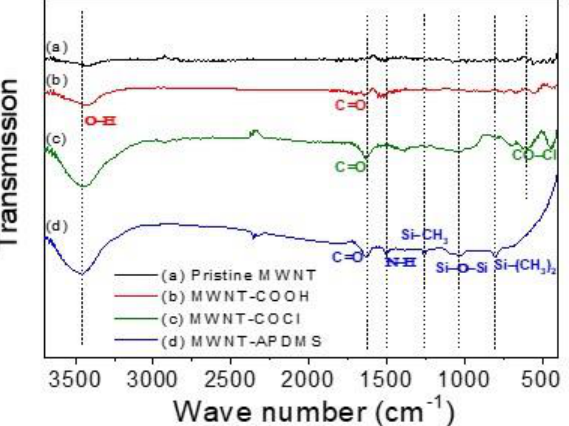
Figure 2. FT–IR spectra of the ( a ) pristine MWNT, ( b ) MWNT–COOH, ( c ) MWNT–COCl, and Figure 2. FT – IR spectra of the ( a ) pristine MWNT, ( b ) MWNT – COOH, ( c ) MWNT – COCl, and ( d ) ( d ) MWNT–APDMS. MWNT – APDMS.